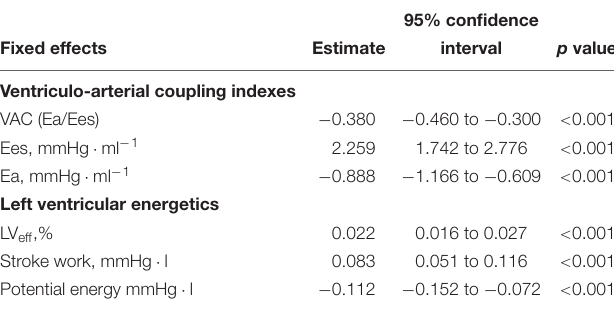
TABLE 7 | Relationship between ventriculo-arterial coupling and left ventricular efficiency and peripheral Ea dyn (radial PPV/SVV) according to a mixed-effect regression